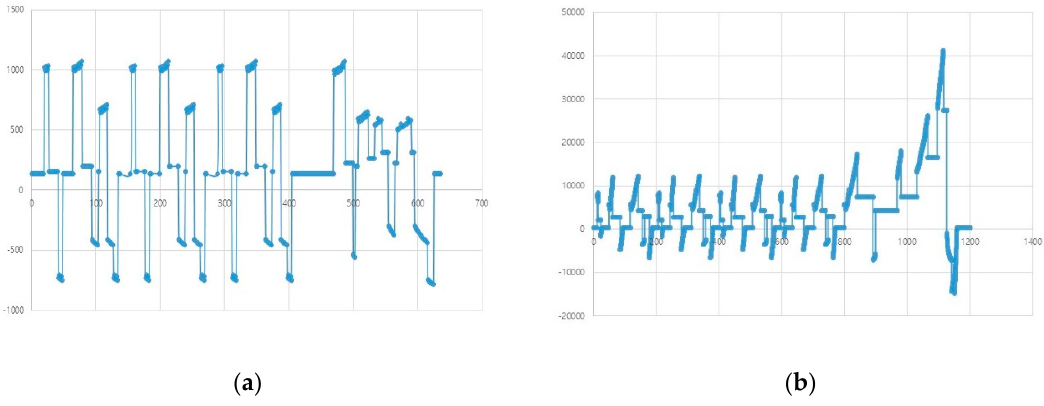
Figure 8. Examples of simulation using the New European Driving Cycle; ( a ) tractive effort or force F t (N), ( b ) power consumption from the battery P bc (W).